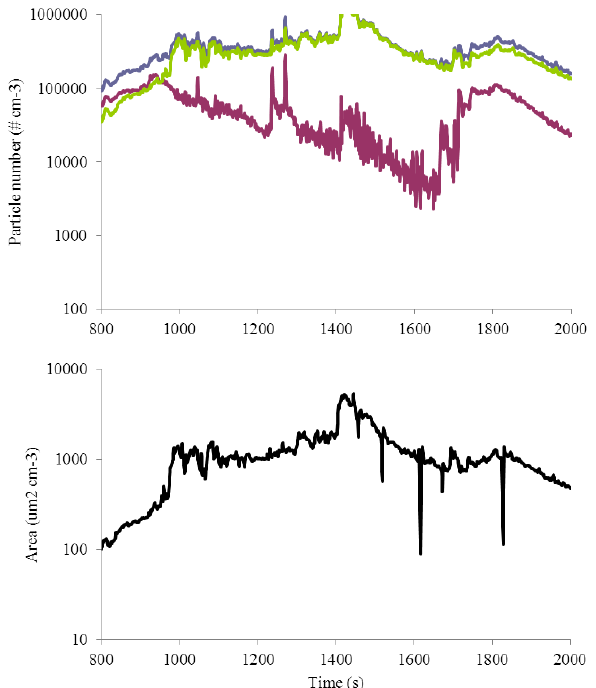
Figure 2. Performance of the three investigated modes (5.6–560 nm blue line, 5.6–16 nm red line, 19–560 nm green line) ( a ) and the particle surface area ( b ) during the Cu-Al soldering operations.